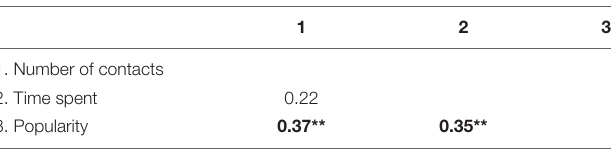
TABLE 3 | Correlations between the social media use